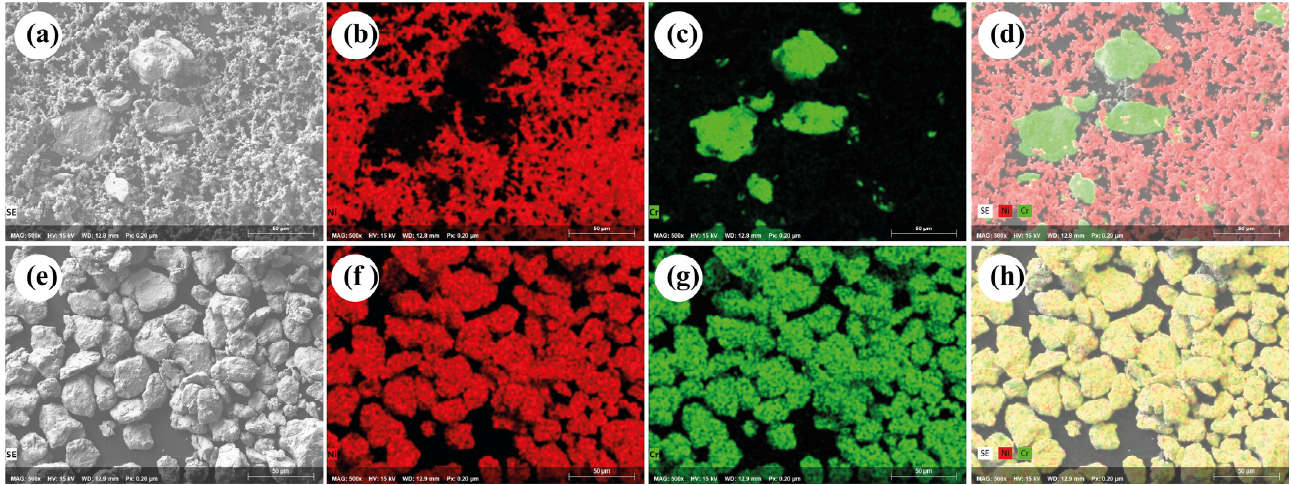
Figure 1. Scanning electron micrograph of ( a ) NiCr-m and ( e ) NiCr-p powders previously sintering processes; ( b ) NiCr-m and ( f ) NiCr-p nickel distribution (red); ( c ) NiCr-m and ( g ) NiCr-p chromium distribution (green); ( d ) NiCr-m and ( h ) NiCr-p nickel and chromium distribution corresponding elemental mapping of the surface.